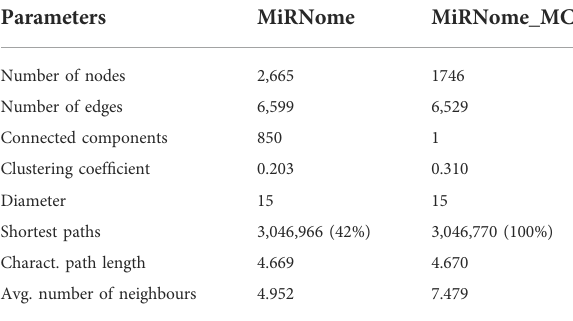
TABLE 2 Main topological parameters computed on MiRNome and MiRNome_MC networks.